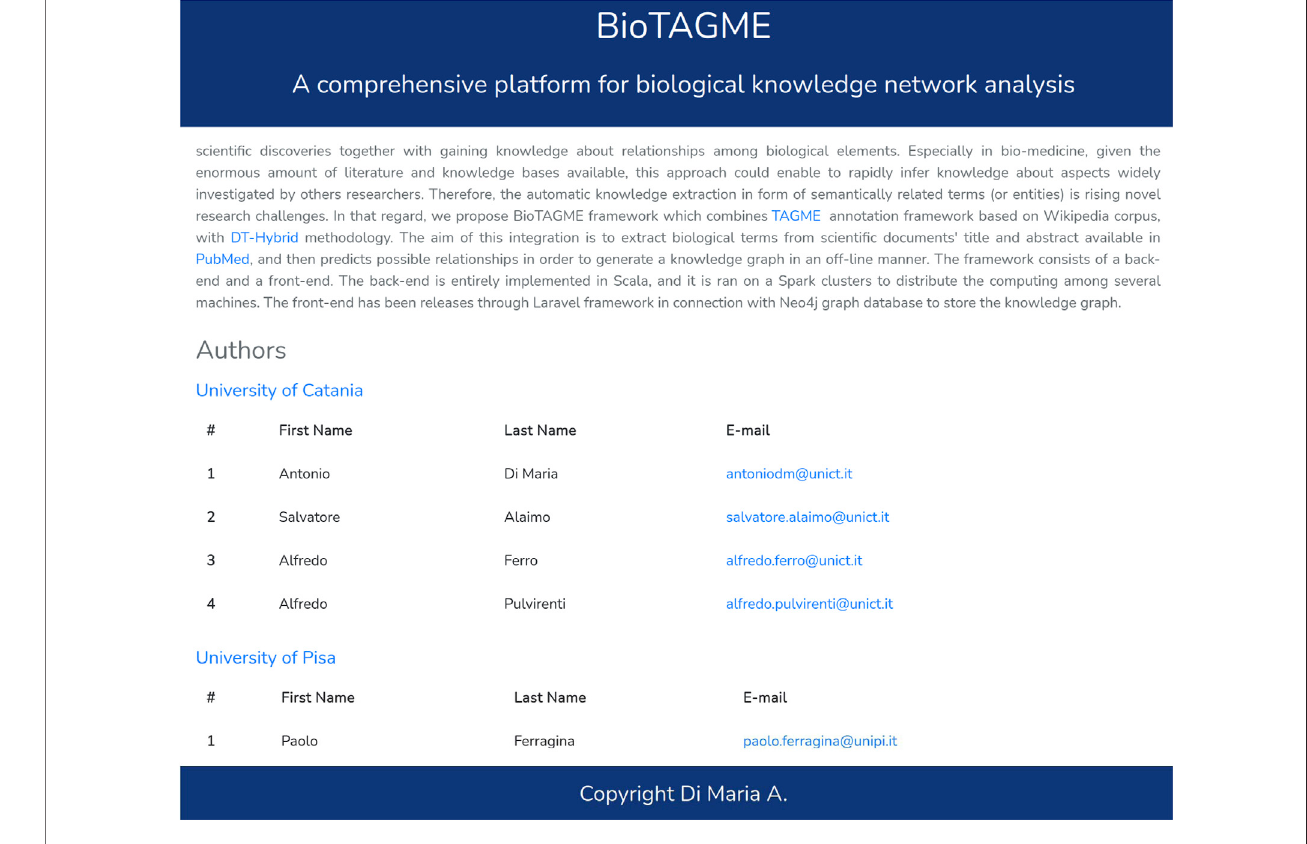
FIGURE 2 | BioTAGME